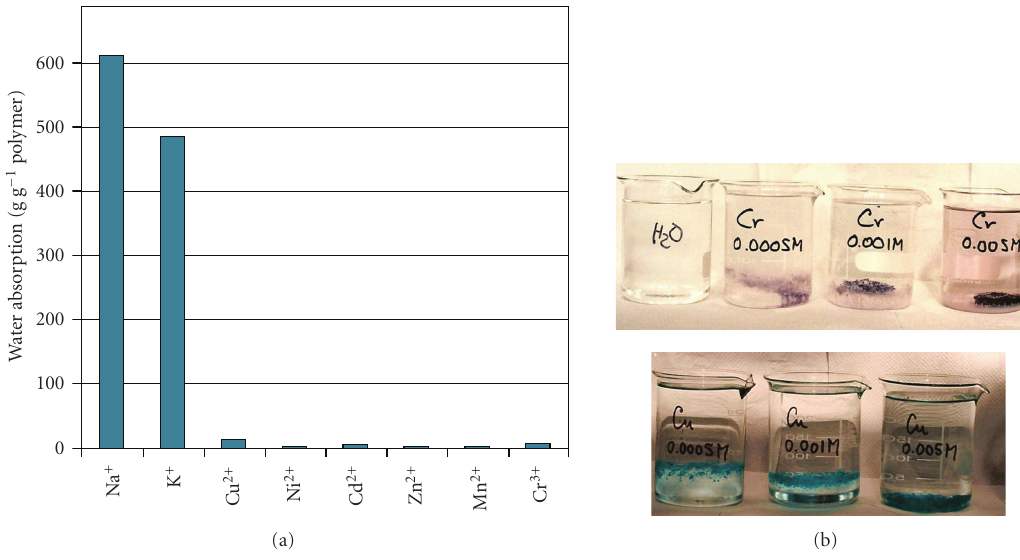
Figure 2: Dehydration of polyacrylates in the presence of di ff erent cations: (a) water absorption by a polyacrylate polymer after equilibration with 0.01 M salt solution, filtration, and reequilibration with de-ionized water, (b) a polyacrylate polymer in the presence of increasing concentrations of Cr 3+ (above) or Cu 2+ (below).